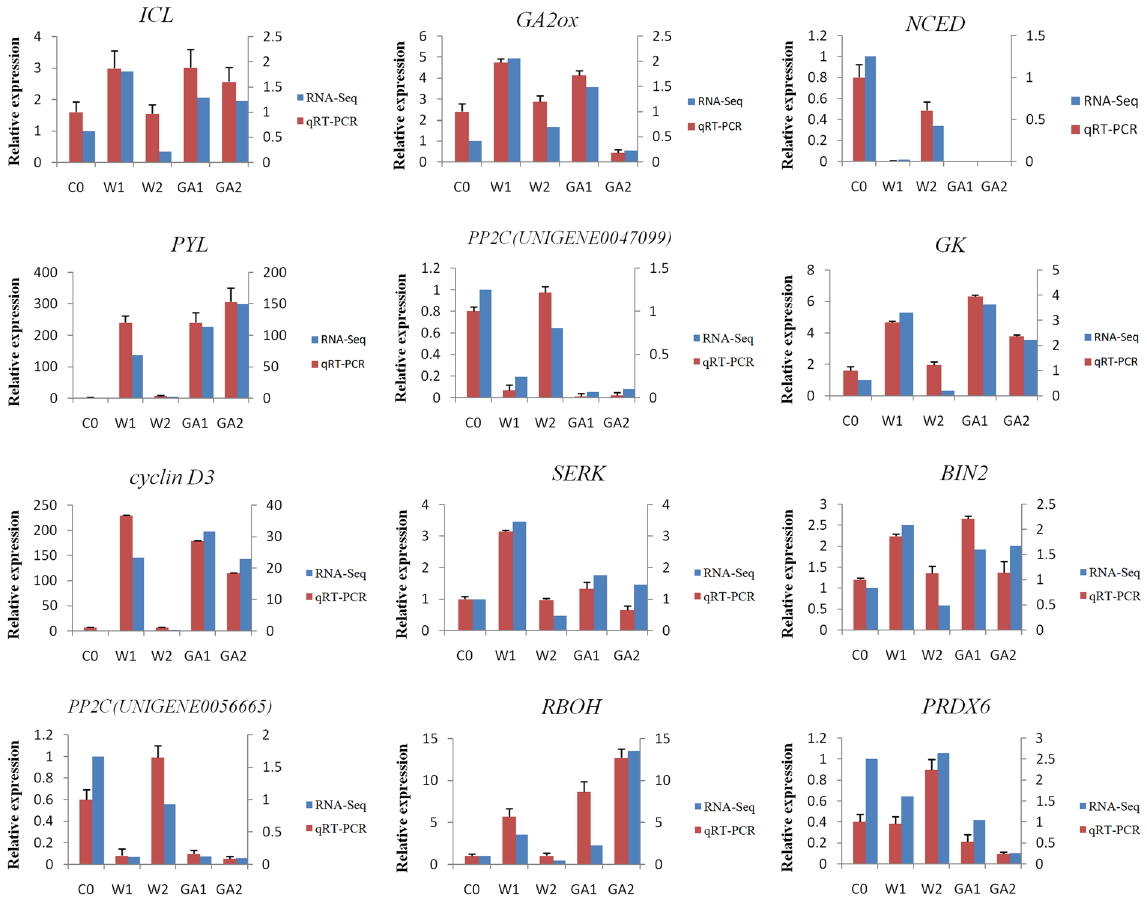
Figure 4. qRT-PCR validation of DEGs during germination of zanthoxylum